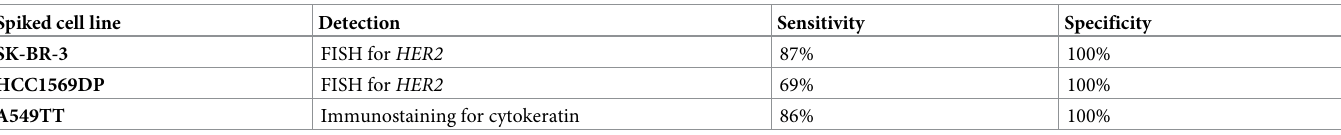
Table 1. Sensitivity and specificity of the CTC detection system. Spiked cell